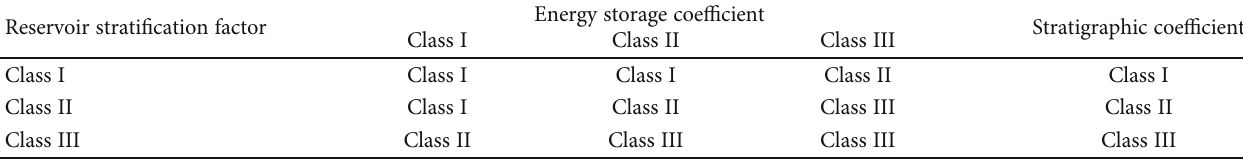
Table 3: Comprehensive classi fi cation evaluation